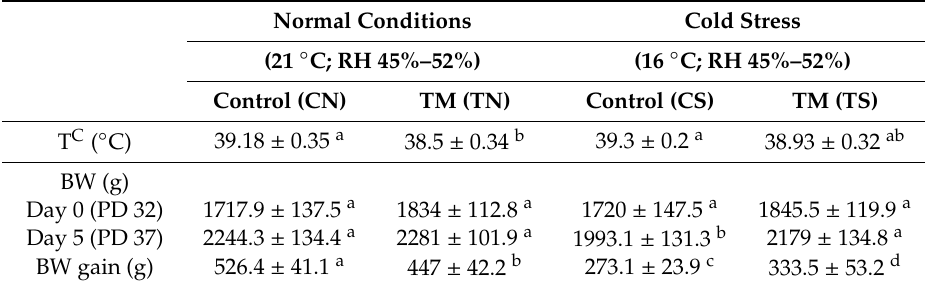
Table 4. E ff ect of post-hatch cold stress for 5 days (post-hatch day (PD) 32 to 37) on cloacal temperature (T C ), body weight (BW), and body weight gain in broiler chickens subjected to embryonic thermal manipulation and